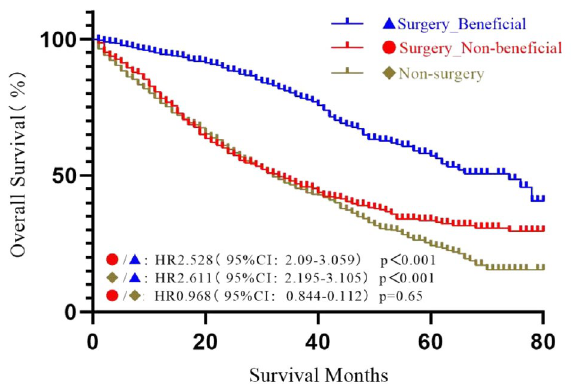
Figure 6. Kaplan–Meier curves to differentiate beneficial and non-beneficial groups based on the predictive model in patients from the SEER database after